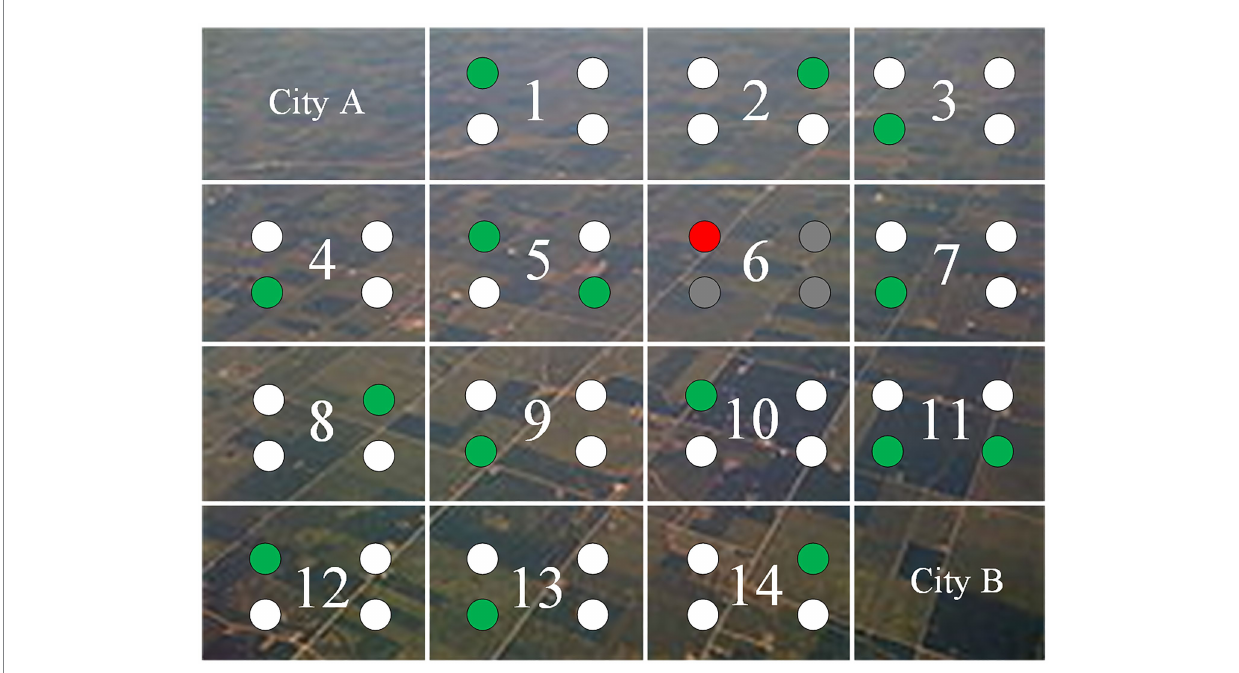
FIGURE 5 Example answers in the exhaustive test 2. Squares marked as 1–14 are the regions between City A and City B. Round dots in a region are locations for sample taking. Region 6 is the demo region with a chosen location marked in red, and the others are marked in grey. Green dots are students’ chosen locations. In this answer, there is at least one chosen location in all 13 regions except region 6, and there is at least one additional chosen location in one of the three regions adjacent to City A (region 5) and City B (region 11). This answer has a score of 4 (see Table